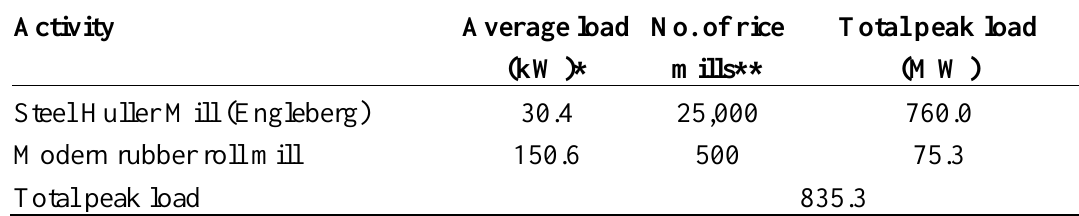
Table 2. Electrical load of rice